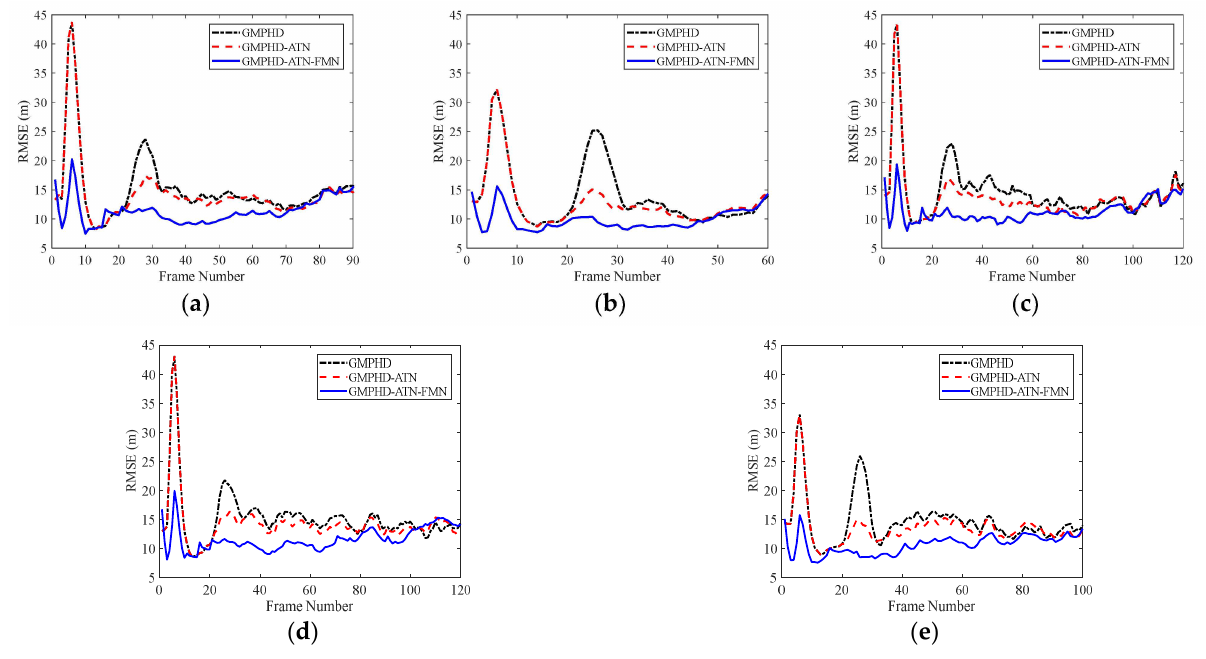
Figure 7. Tracking error comparisons of test datasets: ( a ) group 1, ( b ) group 2, ( c ) group 3, ( d ) group 4, and ( e ) group 5.